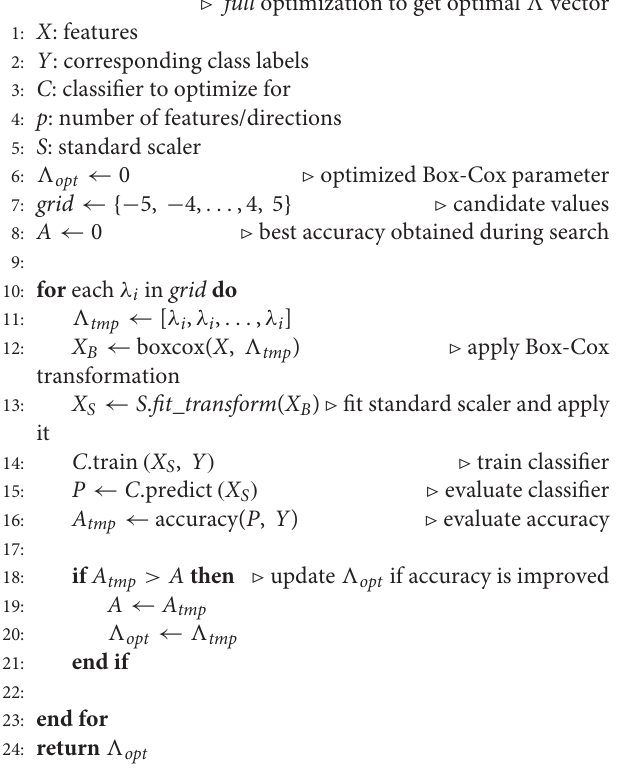
Algorithm 7 : Spherical grid search( X , Y , C ) ⊲ full optimization to get optimal 3 vector